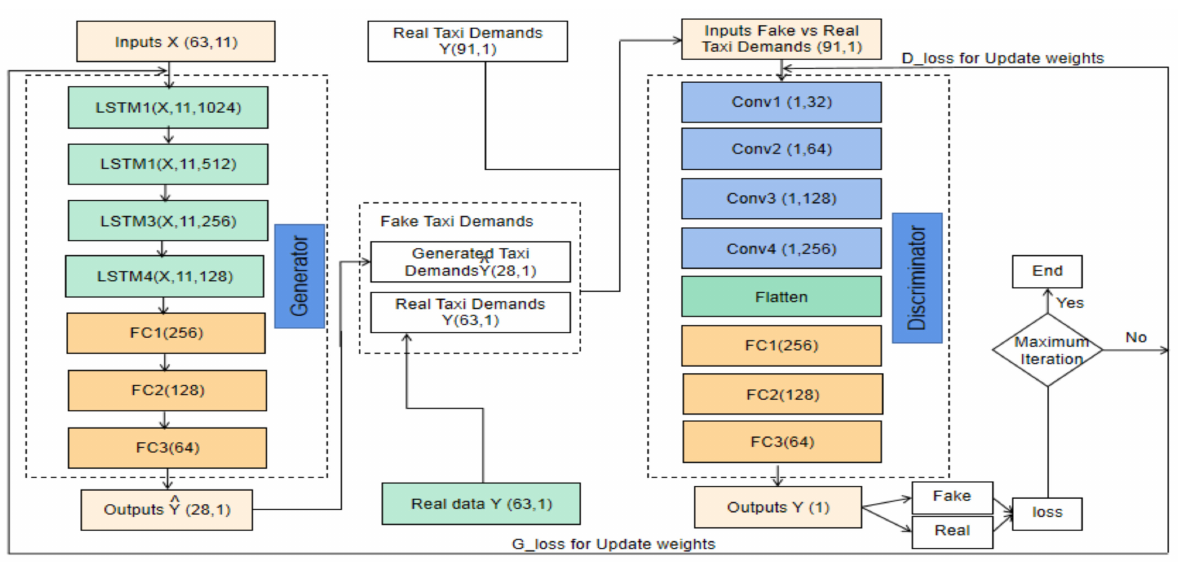
Figure 15. The architecture of GAN_LSTM_CNN